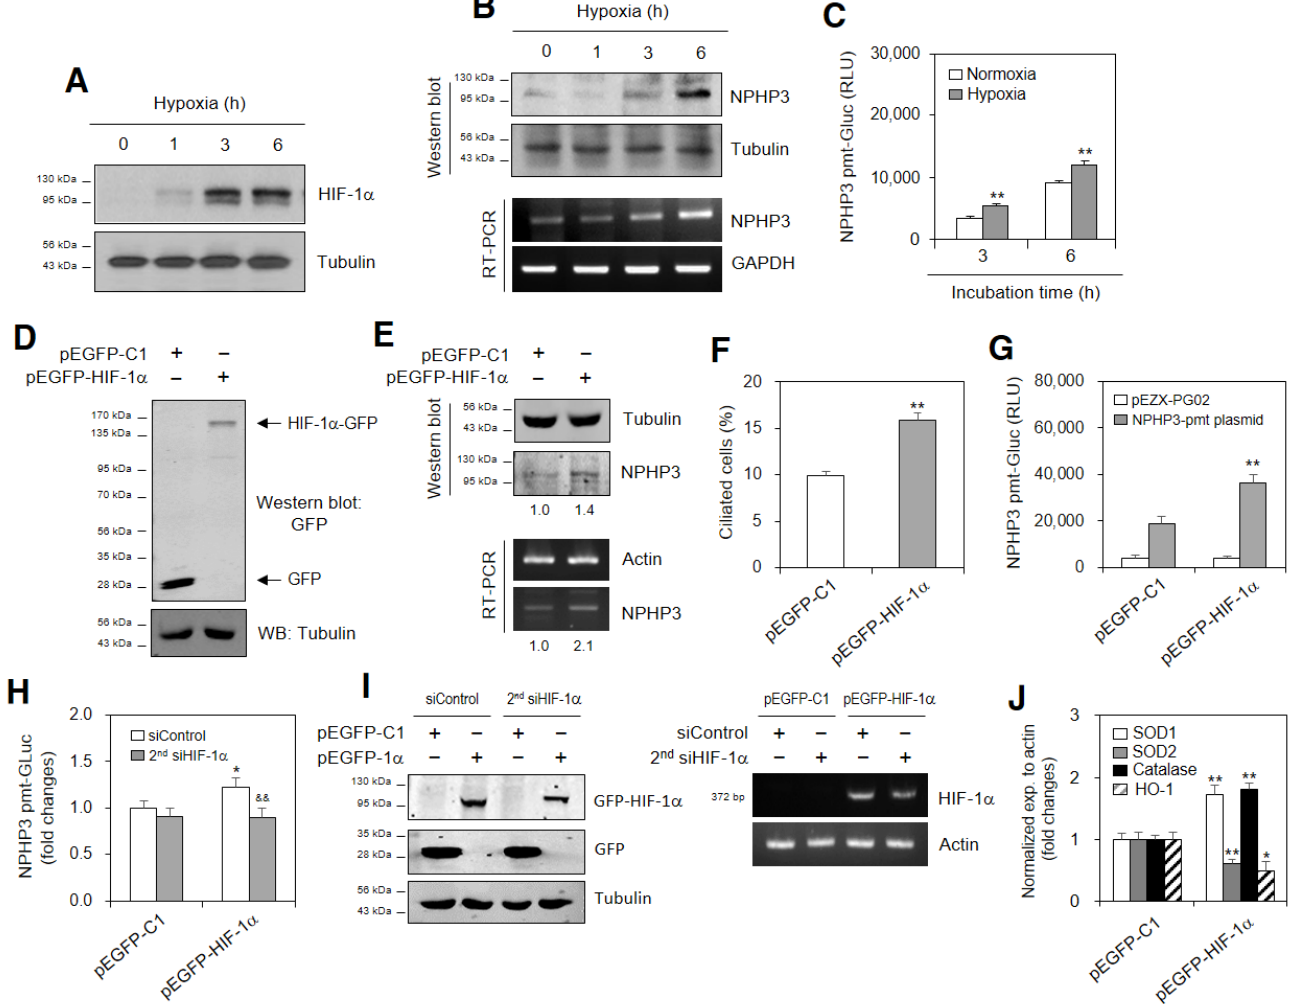
Figure 3. HeLa cells incubated under hypoxic condition increased primary cilium formation. ( A , B ) Cells were incubated under normoxic or hypoxic condition for up to 6 h. Cell lysates were prepared. HIF-1 ( A ) and NPHP3 ( B top) proteins were detected by Western blot analysis. Total RNA was